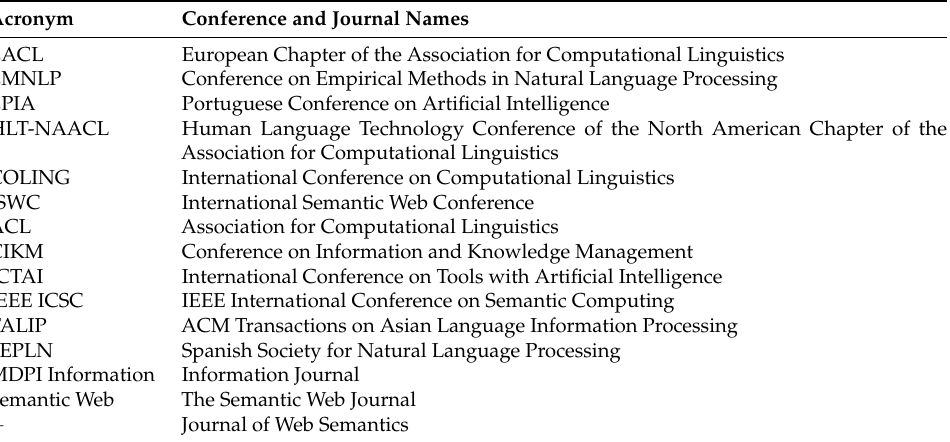
Table 3. Conference and journal names and